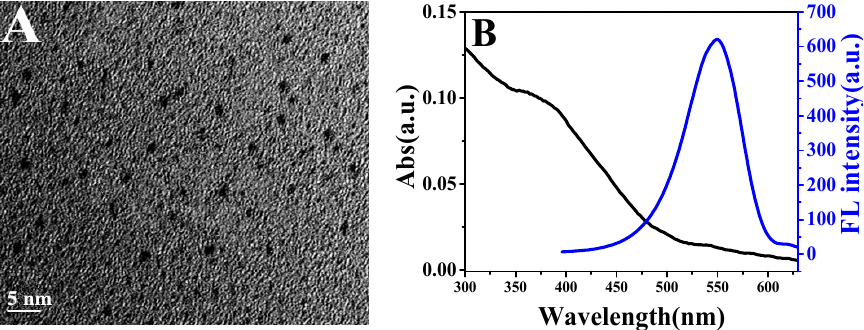
Figure 1. Characterization of the enzymatically generated CdS QDs. ( A ) HRTEM image and ( B ) the absorption (black line) and fluorescence (blue line) spectrum of PO 43 − -capped CdS QDs produced by the enzymatic hydrolysis of 1-thio- β - D -glucose. PO 43 ´ -capped CdS QDs were formed in the presence of GOx (20 mg/L), 1-thio- β - D -glucose (1 mM) and Cd 2+ (1.5 mM), pH = 4.0.